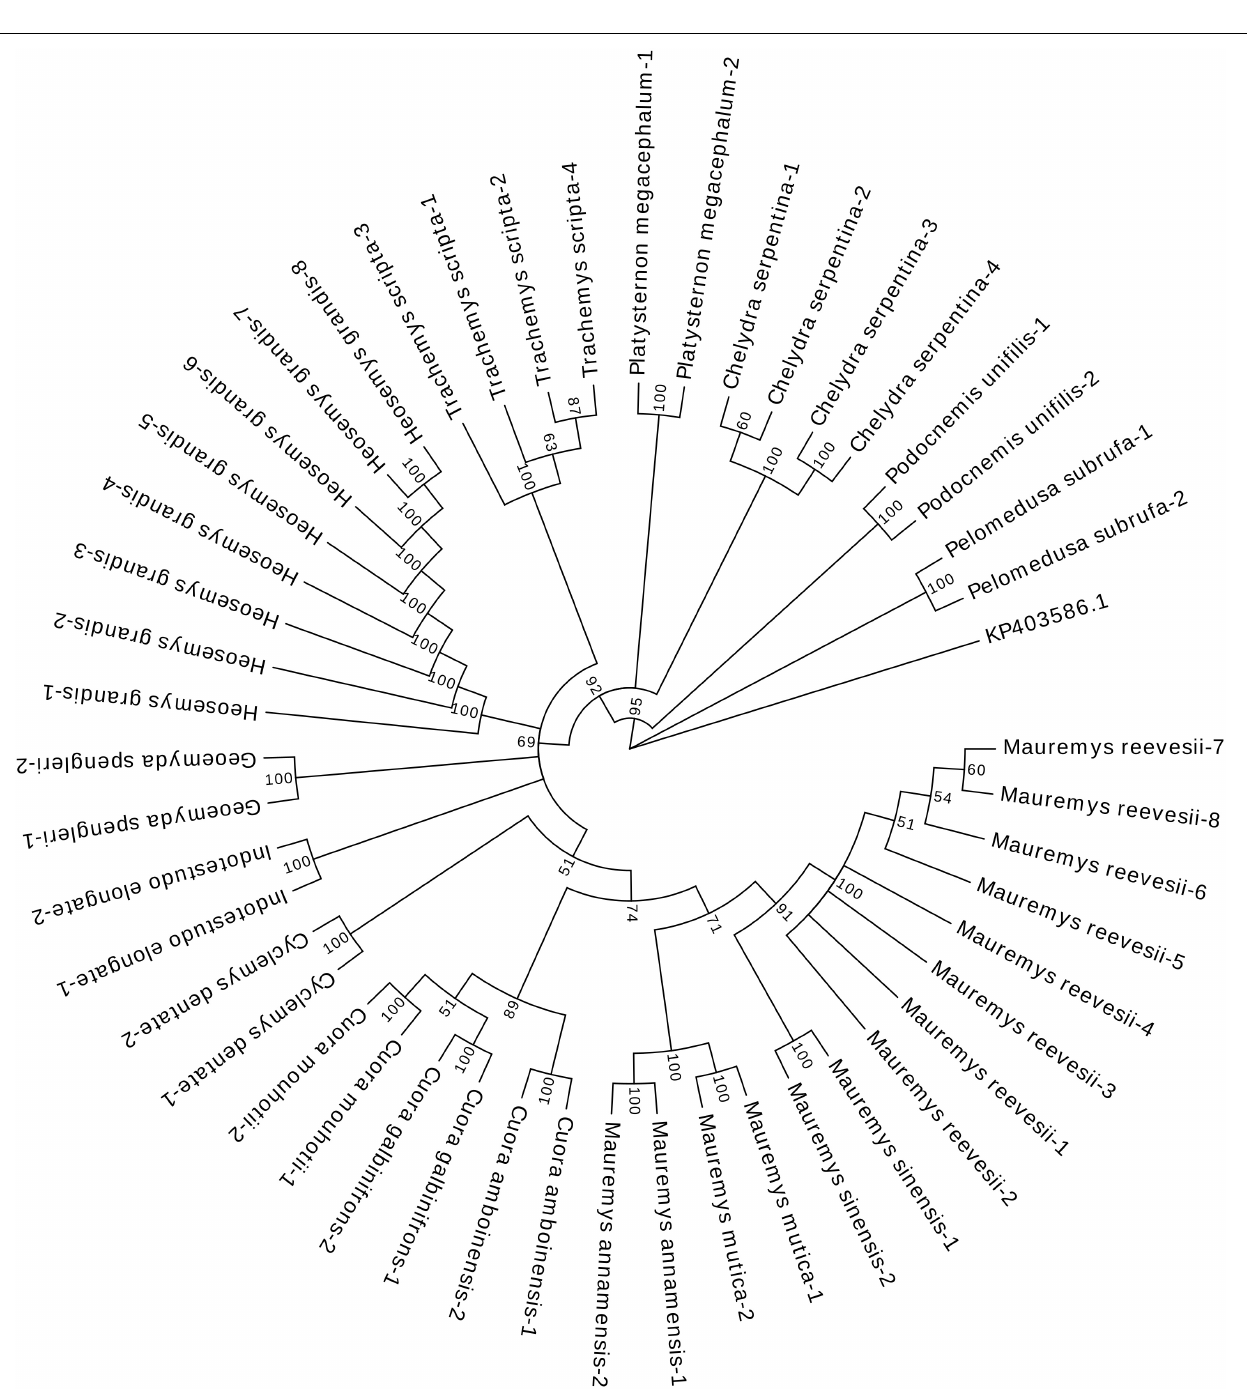
FIGURE 2 | Results of the neighbor-joining tree based on COI sequences of the 48 turtle samples. The value represented the percentage of these branches in the bootstrap test, indicating whether the data adequately support their associated partitions. The closer to 100, the higher the credibility.